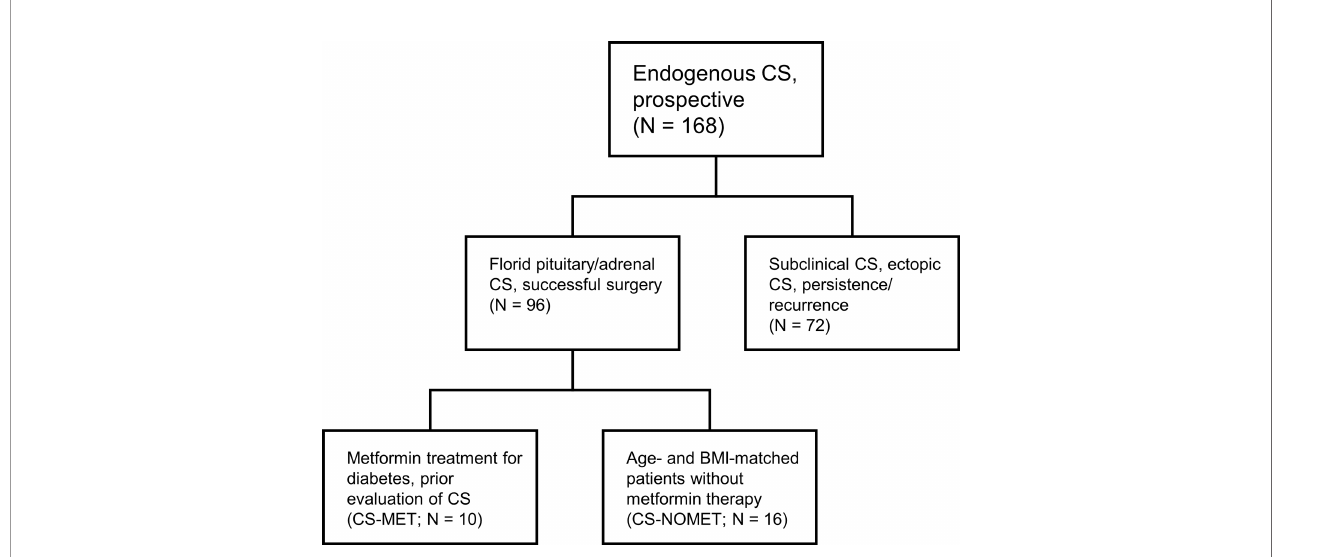
FIGURE 1 | Patient selection. CS, Cushing ’ s syndrome; BMI, body mass